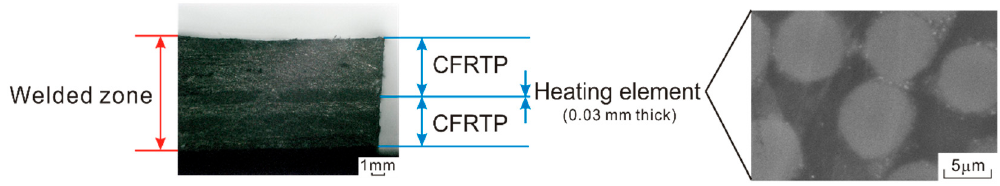
Figure 13. Digital microscope image (left side) and SEM image (right side) of the cross-section of the welded zone of CNT10.